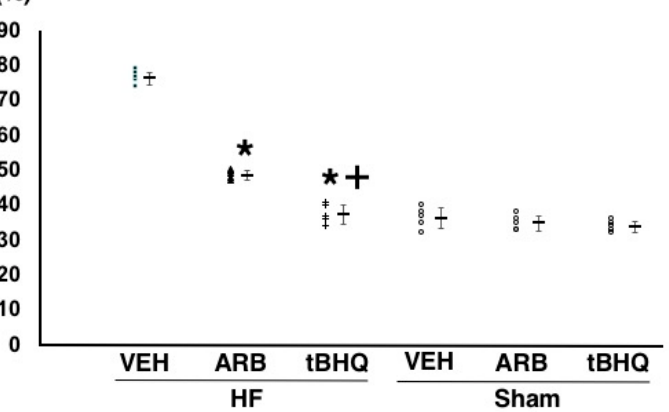
Figure 4. Low frequency component of the systolic arterial pressure variability of heart failure treated with intracerebroventricular (ICV) infusion of vehicle (HF-VEH), or with ICV imfusion of angiotensin II type 1 receptor blocker (HF-ARB), or with ICV infusion of nuclear factor erythroid 2-related factor 2 activator, tert -butylhydroquinone (HF-tBHQ), or sham treated with ICV infusion of VEH, or with ICV infusion of ARB, or with ICV infusion of tBHQ. n = 5 for each group. All data are shown in dot plot and mean ± standard deviation. * p < 0.05 vs. HF-VEH in HF-ARB and HF-tBHQ. + p < 0.05 vs. HF-ARB in HF-tBHQ.